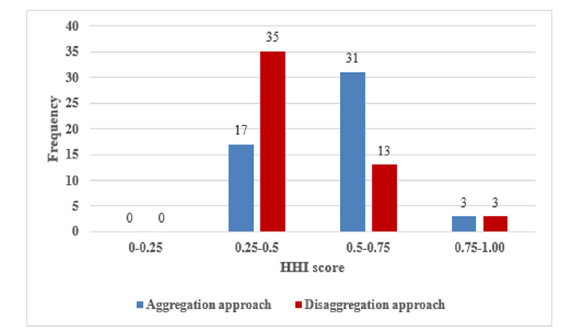
Fig. 3 Distribution of average HHI scores in 51 Vietnamese universities 2015 –